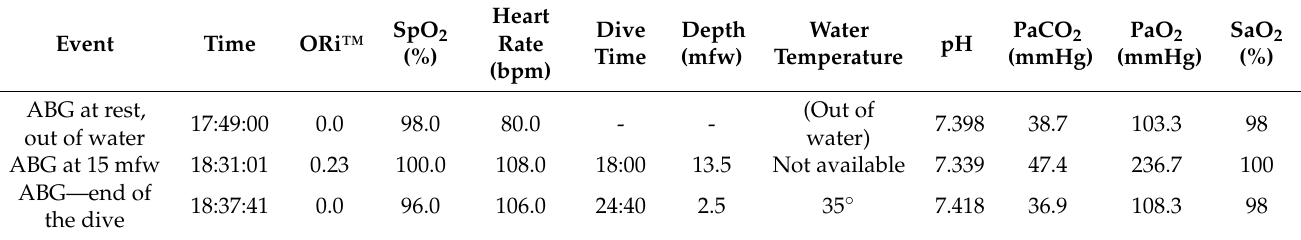
Table 1. Comparison between arterial blood gases (ABGs) and peripheral oxygen saturation (SpO 2 ) measured through a pulse oximeter and the oxygen reserve index (ORi™) during three different